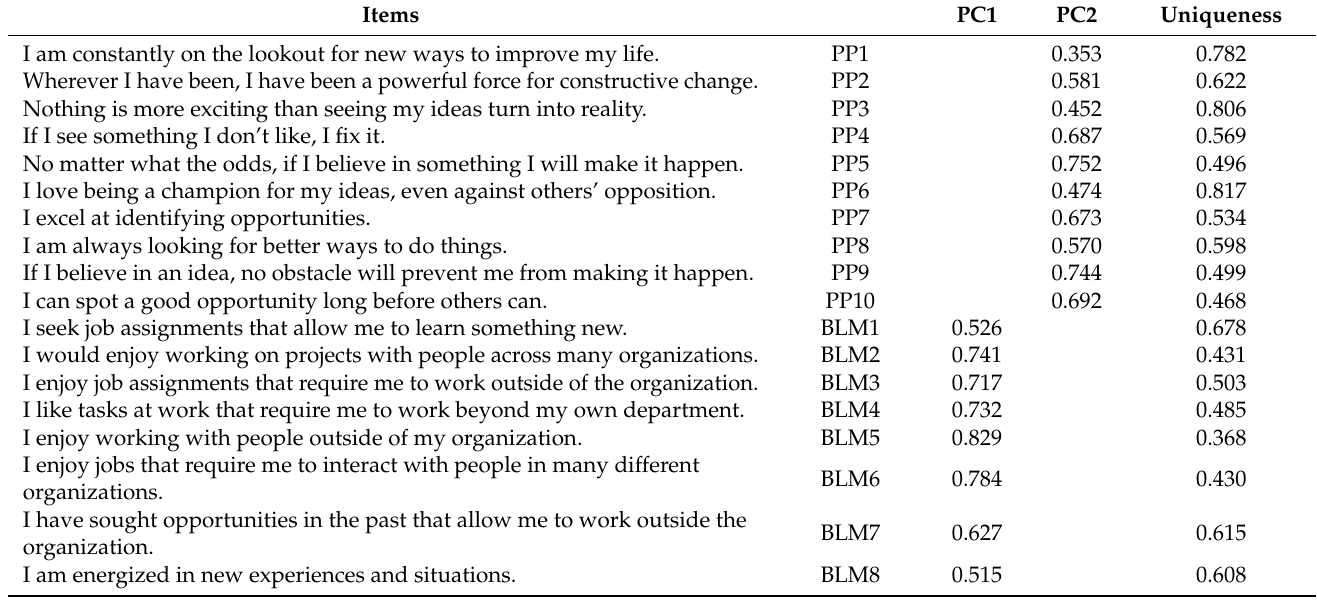
Table 2. PCA, Component